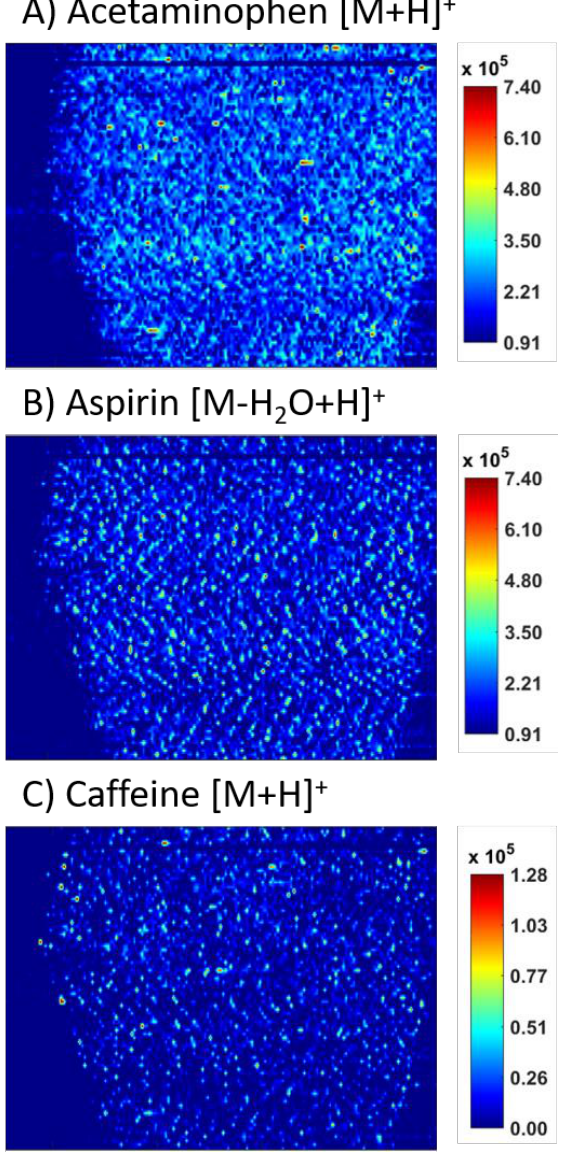
Figure 3. MS images of the three APIs in brand “A” over the counter tablets, including ( A ) acetaminophen, ( B ) aspirin, and ( C ) caffeine.